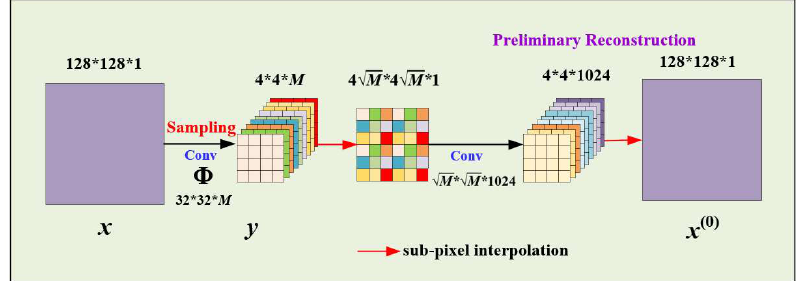
Figure 3. Structure diagram of a large convolutional layer sampling and preliminary reconstruction network. tion